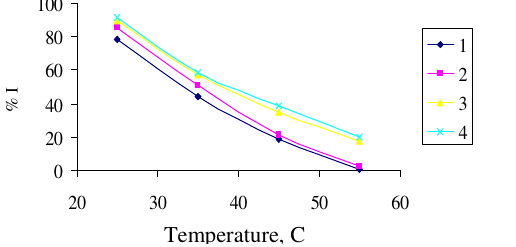
Figure 4. Inhibition efficiency (%I) at 1 × 10 -4 M of compounds ( 1- 4 ) for corrosion of